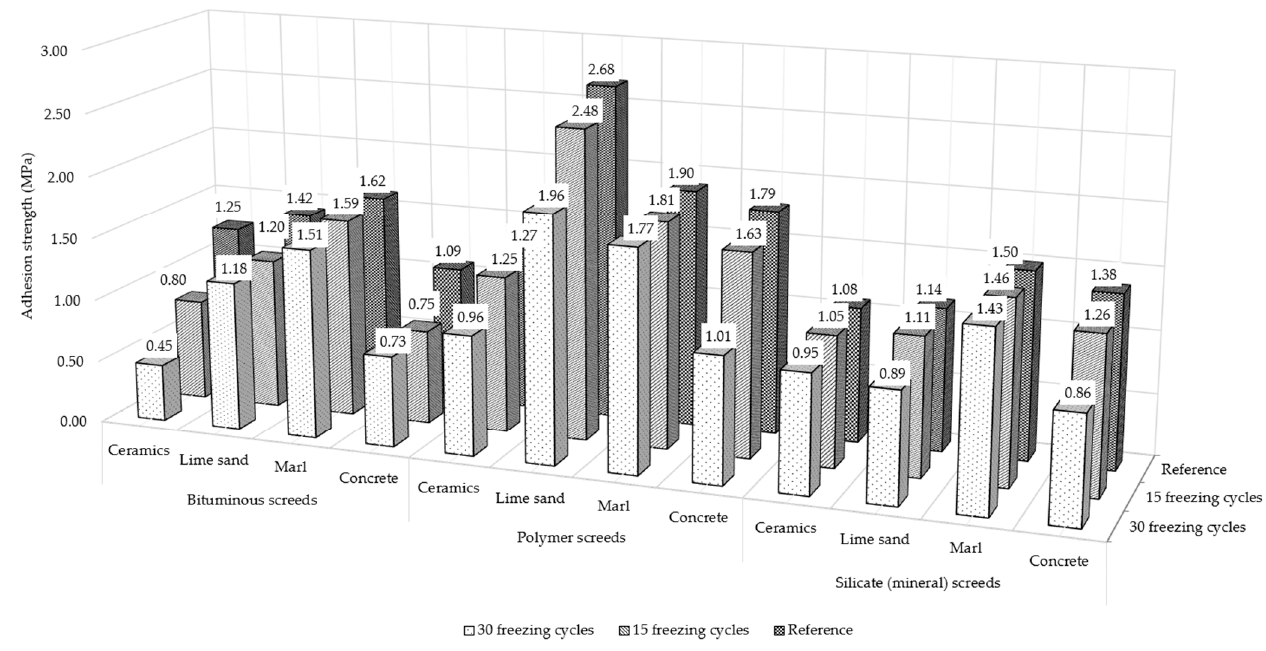
Figure 15. Results of the tear-off test, tensile strength.